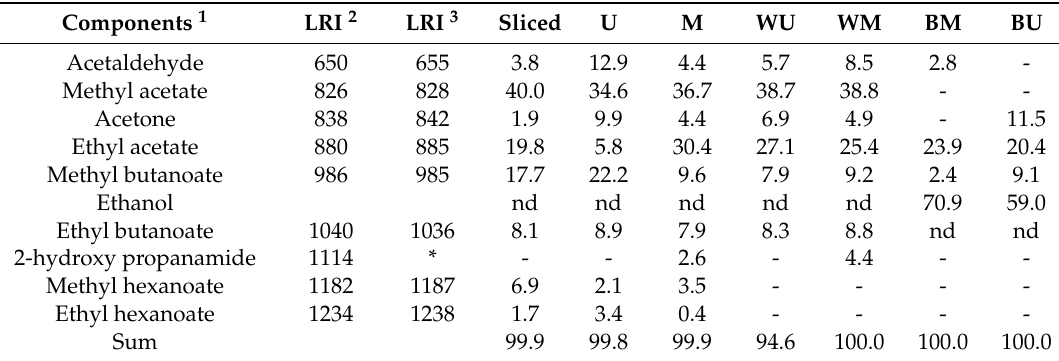
Table 1. Fresh strawberry HS-GC peak area